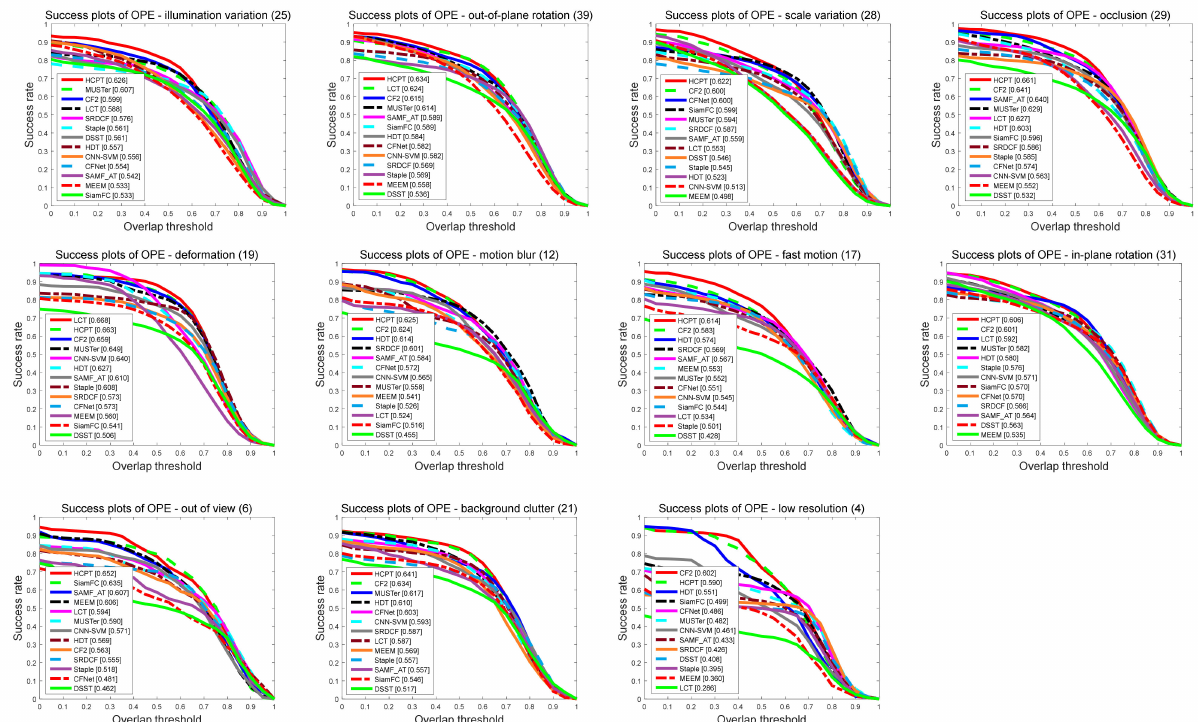
Figure 8. Success rate plots of 11 tracking challenging on OTB-2013. The plots illustrate the experimental results using 11 attributes. The legend shows the success rate and we show the results of 12 trackers.